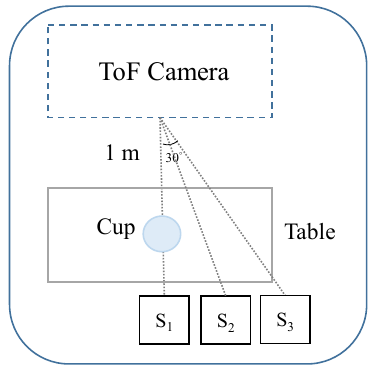
Figure 3. Setup of the recording environment: S 1 and S 3 stand for the known-view data, whereas S 2 stands for the unknown-view data.